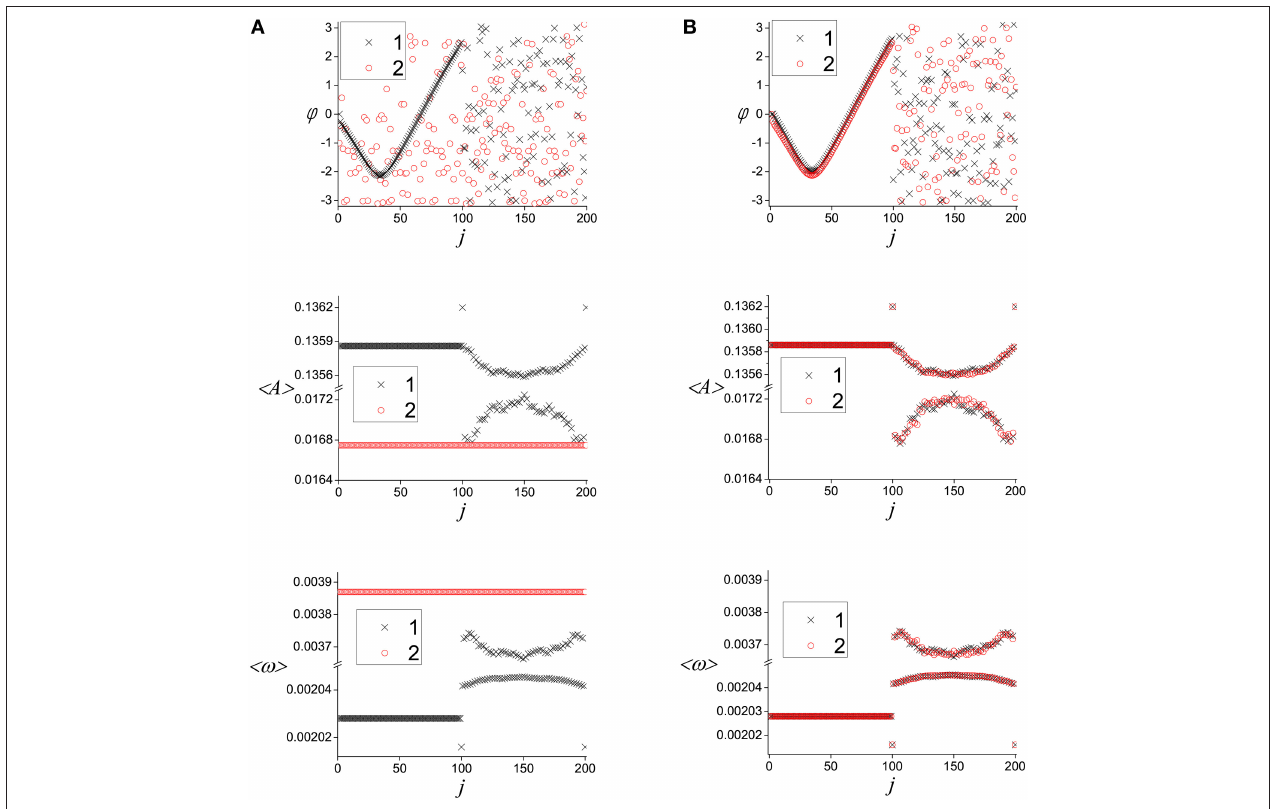
FIGURE 2 | Cloning of chimera state in system (1). Distribution of instant phases ϕ , average amplitudes < A > and average frequencies < ω > (from up to bottom) at the initial instant of time (A) ; after the interaction (B) . Indexes “1” (black cross) and “2” (red circle) correspond respectively to the first and second layer states. Parameters values: a = 0.32, b = 0.79, c = 1.166, ε = 0.001, d r = 0.006, d = 0.06, T c = 1,000, and N =